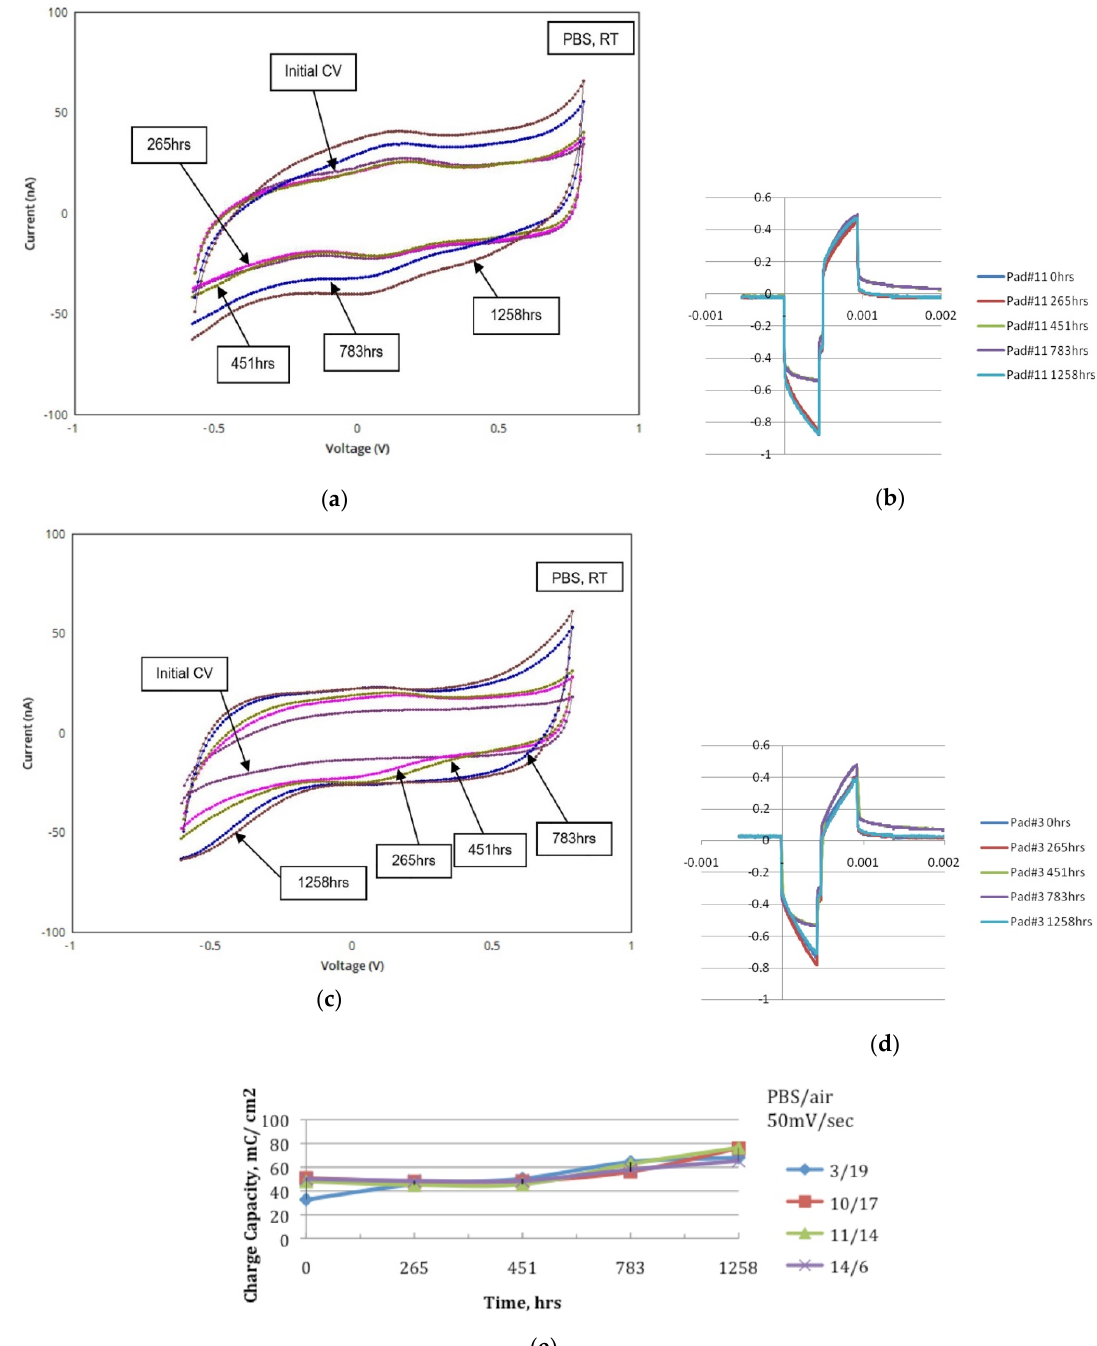
Figure 8. ( a , b ) Cyclic voltammograms versus time for a 40 μm diameter microfabricated SIROF-coated penetrating post electrode. Note the evolution of the charge capacity, proportional to the enclosed area; the corresponding voltage waveforms for 1 msec bi-phasic current pulses are shown at right. ( c , d ) CV plots and voltage waveforms over time for a corresponding 40 μm diameter planar electrode, respectively; ( e ) charge capacity versus time for a 40 μm diameter planar electrode (#3/19; blue trace) and for three, 40 μm diameter penetrating post electrodes (#’s 10/17. 11/14. and 14/6; red, green, and purple traces) showing gradual improvement over 1000+ hrs. of pulsing, likely due to hydration of the SIROF films.